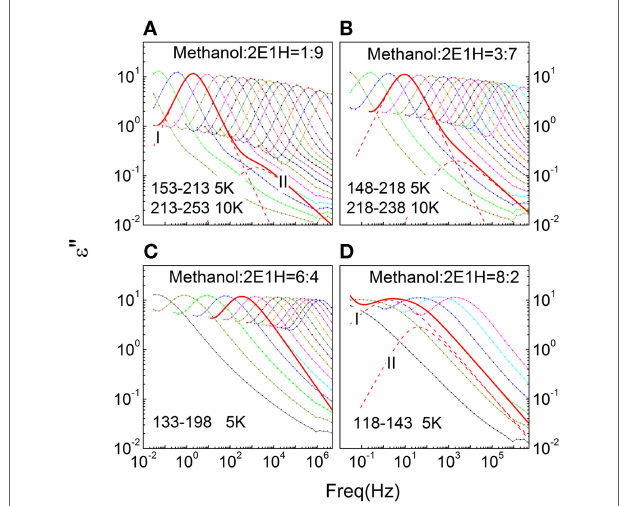
FigUre 1 | Frequency-dependent dielectric loss ( ε′′ ) spectra of methanol – 2-ethyl-1-haxanol (2e1h) mixtures with four mole fractions (a–D) . The fits of Havriliak–Negami equation to the representative curves are